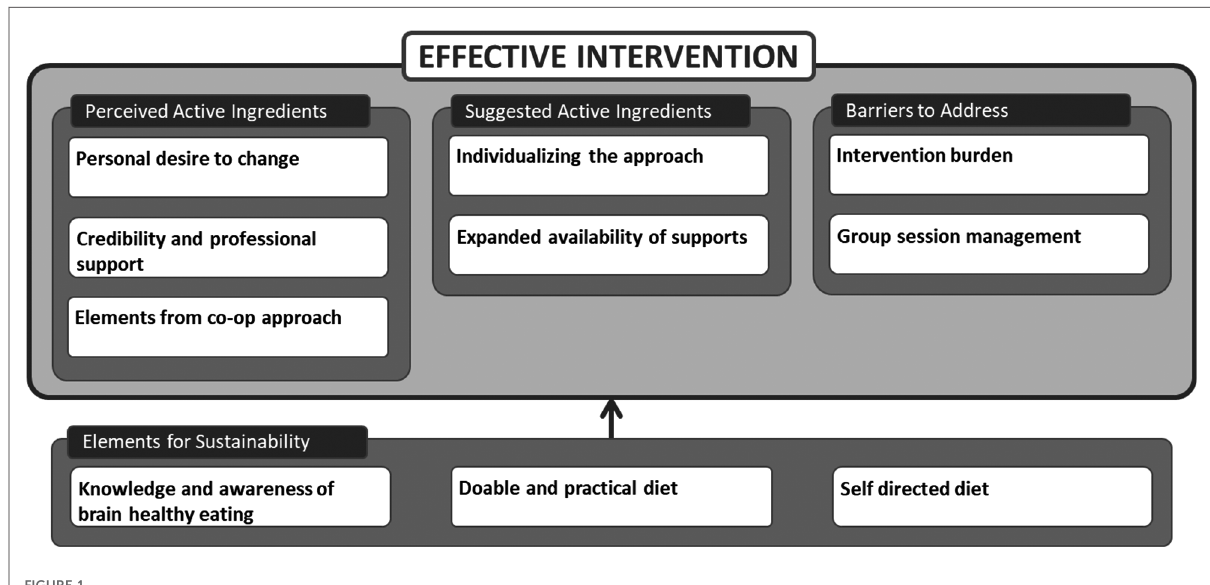
FIGURE 1 Posited ingredients and elements necessary for an effective and sustainable brain healthy eating